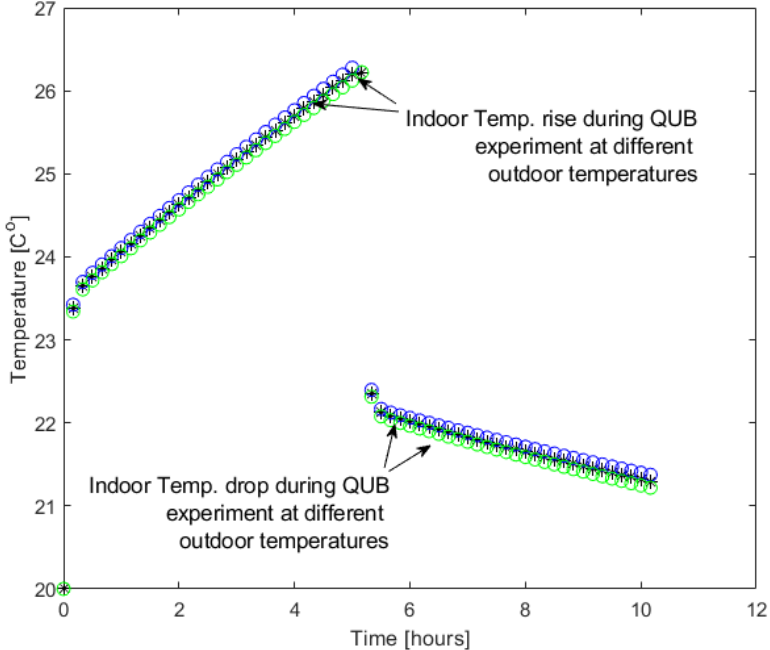
Figure7. QUBexperimentsatdi ff erentoutdoortemperatures: atpredictedaverageoutdoortemperature Figure 7. QUB experiments at different outdoor temperatures: at predicted average outdoor (black asterisks) of 10 ◦ C, at 8 ◦ C (green circles), and at 12 ◦ C (blue temperature (black asterisks) of 10 °C, at 8 °C (green circles), and at 12 °C (blue circles).